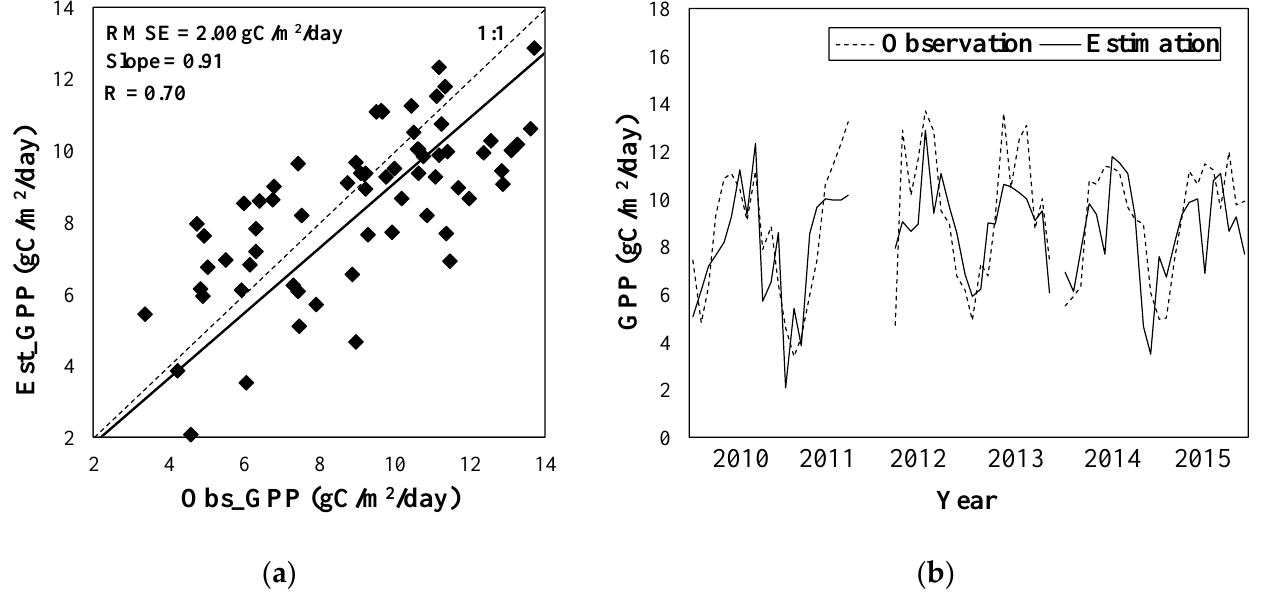
Figure 3. Accuracy assessment of GPP: ( a ) Comparison between the estimated GPP and the GPP from Flux tower; ( b ) Time series of monthly estimated GPP and Flux tower GPP. According to [53], we extended the range of two free parameters, VPD 0 and ε max , 10% downward and upward, respectively, from the base range covered by all PFTs (Plant functional Types). EC-LUE was conducted by inputting all possible combinations of free parameters, with VPD 0 taking a step of 0.01 kPa, and ε max having a 0.01 gC MJ − 1 step. The estimated outputs were compared with the tower-based GPP using MAE (mean absolute error), MAPE (mean absolute percentage error), and RMSE; the optimal values